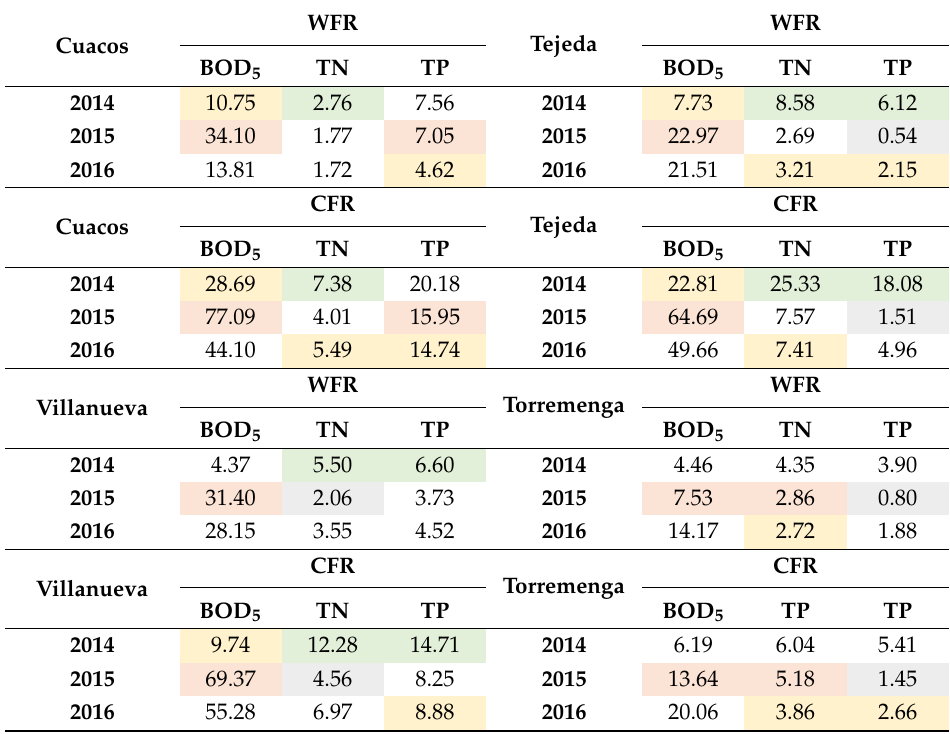
Table 6. Annual average values of WFR and CFR for four WWTPs, 2014–2016. Good environmental performance limit (GE) is indicated by green cells, good manager performance limit (GM) by yellow cells, operational scenario to reduce consumption (OS) by orange cells, and poor environmental performance limit (PE) by grey cells. The values represented in Figure 6 have been written in red.